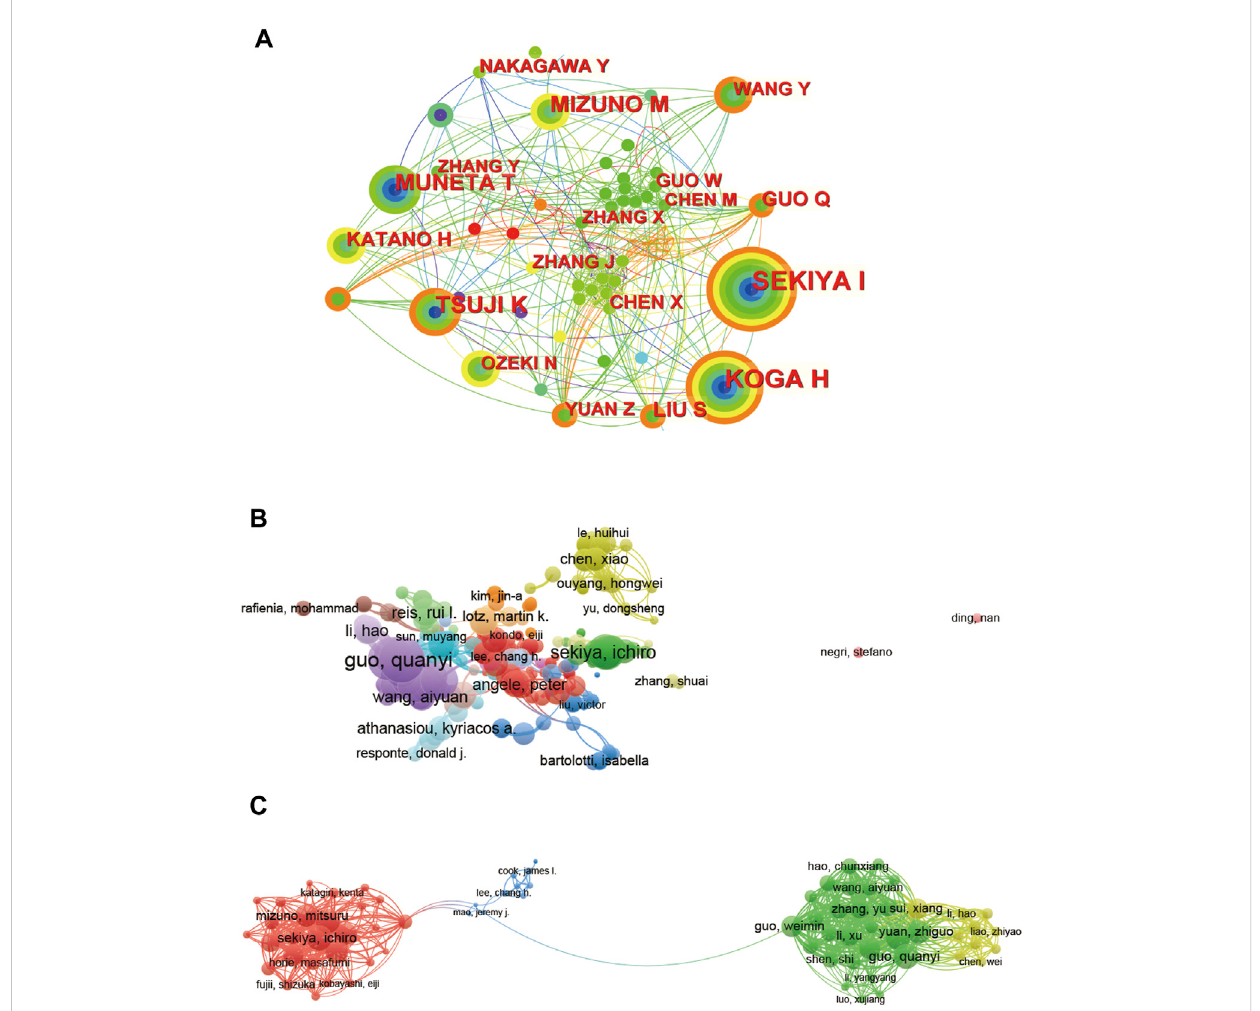
FIGURE 6 CiteSpace and Vosviewer network visualizations of author collaboration analysis regarding stem cells for meniscal regeneration. Author collaboration analysed by CiteSpace (A) and Vosviewer (B) . (C) Network visualization diagram of authorship-author analysis based on Vosviewer. Author collaborationauthorsare indicated bythenode. The collaboration relationshipisindicated bytheline connecting thenodes.The node areagrows asthe number of collaborations increases. The colors from green to orange represent different years from 2012 to 2022.